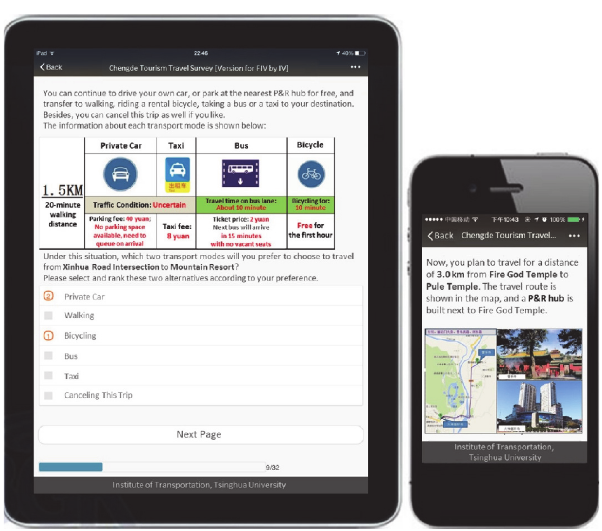
Figure 2: Interface of SP survey on tablet PC and mobile phone (translated from